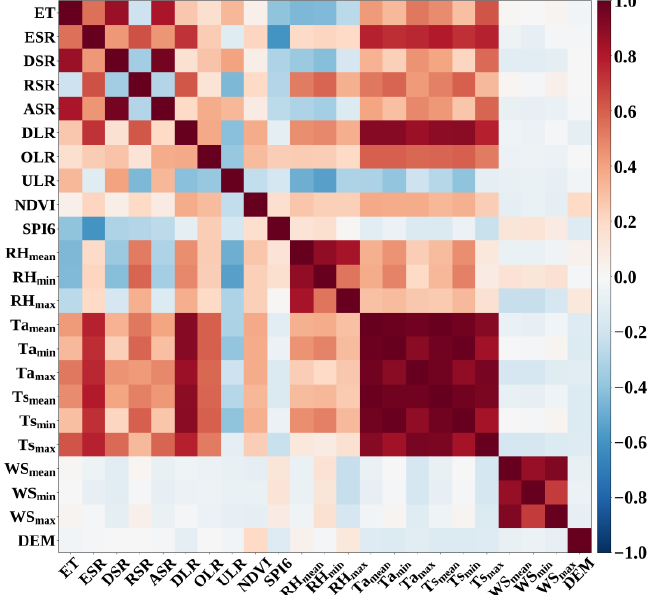
Figure 4. Correlation coefficient between the input variables in the matchups from 25 July 2019 to